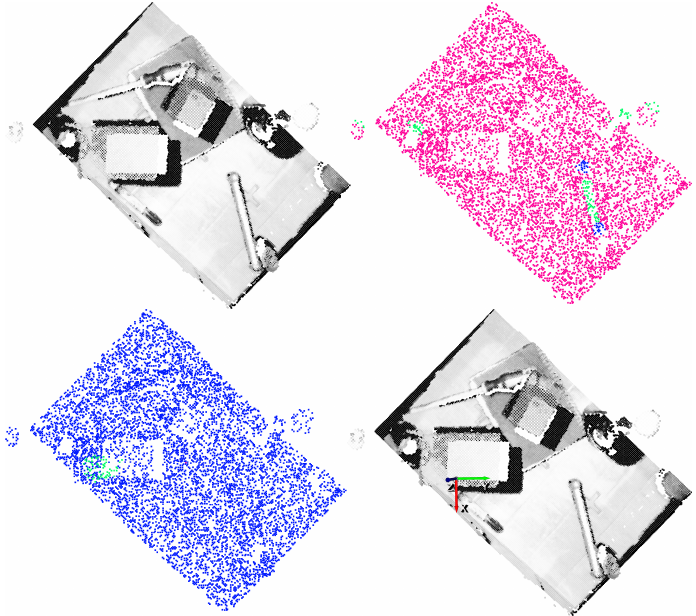
Figure 19. Gripper result example for n = 2. Top-left: Point cloud of the scene. Top-right: Ground- truth annotation. Bottom-left: Top-1% predictions. Bottom-right: Top-1 grasping point. The vertical orientation for the gripper is determined by the y (green) axis.